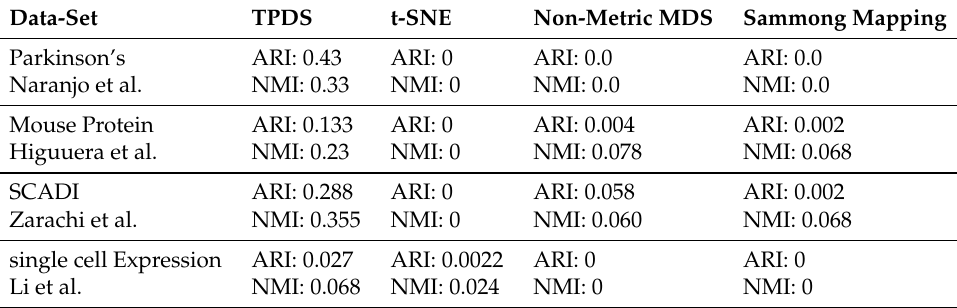
Table 1. Result of clustering purity after applying